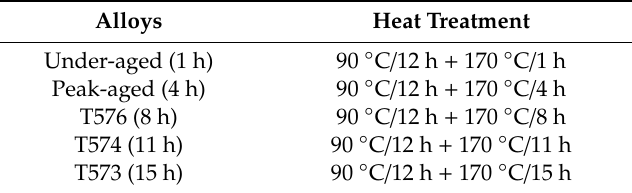
Table 2. Heat treatment